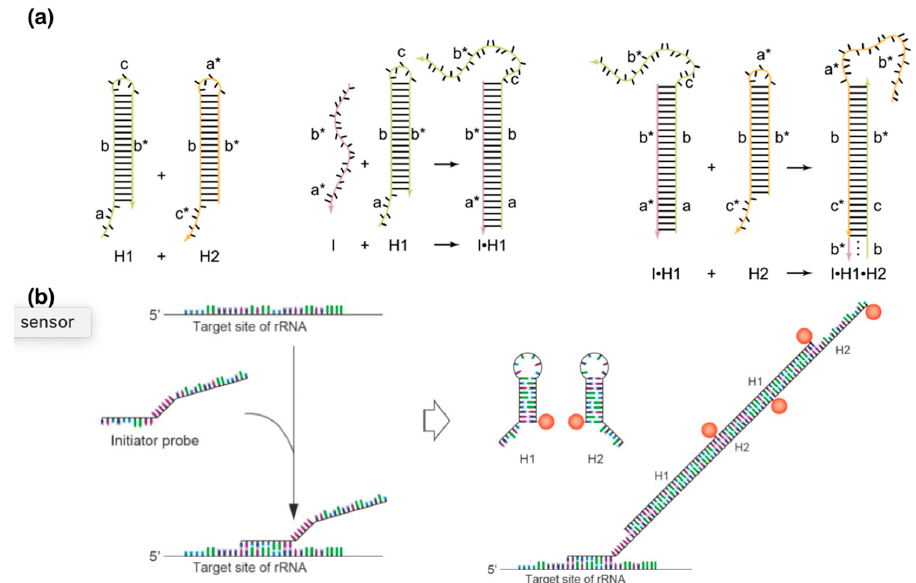
Figure 10. Principle of enzyme-free DNA hybridization chain reaction amplification: ( a )